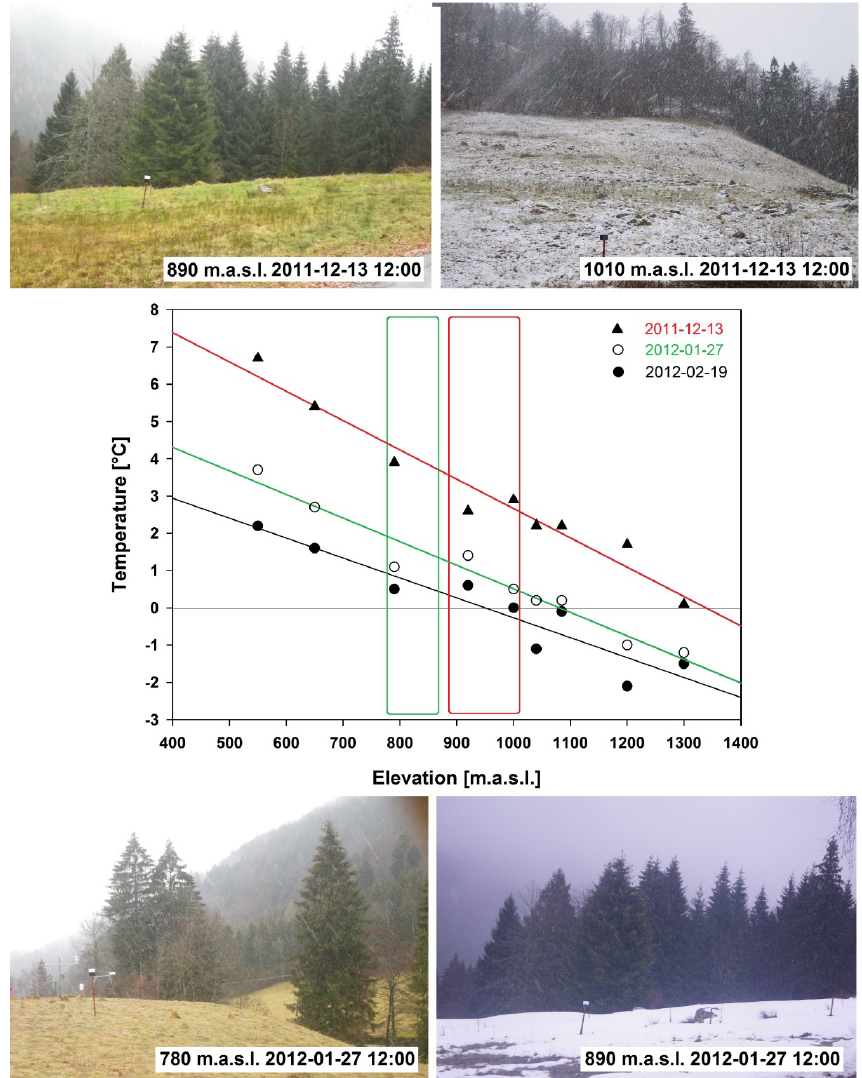
Fig. 14. Temperature profiles for different precipitation events in the Brugga catchment. Time-lapse images could be used to determine the state of